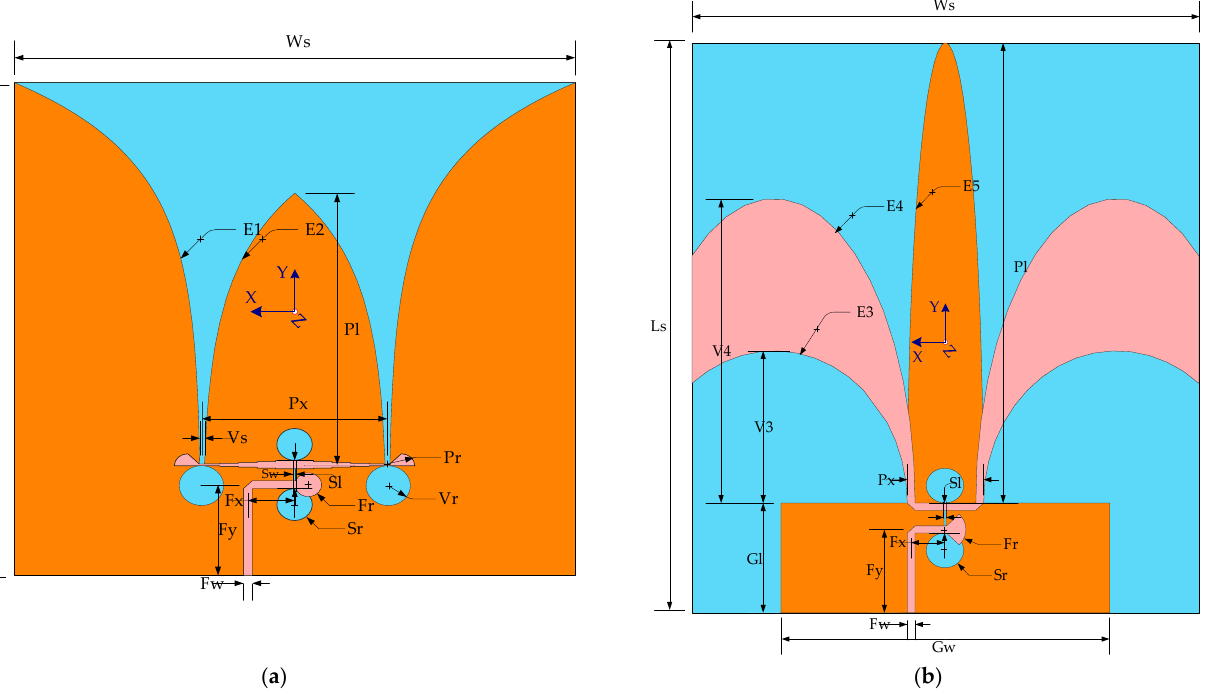
Figure 1. Structure of antenna with feed, substrate, and ground layer structure: ( a ) podal antenna; ( b ) antipodal antenna. Table 1. Parametric dimensions of the proposed two antennas structures.